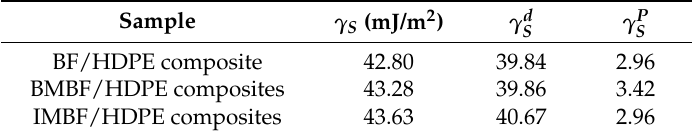
Table 4. Surface energy calculated by Owens-Wendt-Rabel-Kaelble (OWRK) equation. Sample